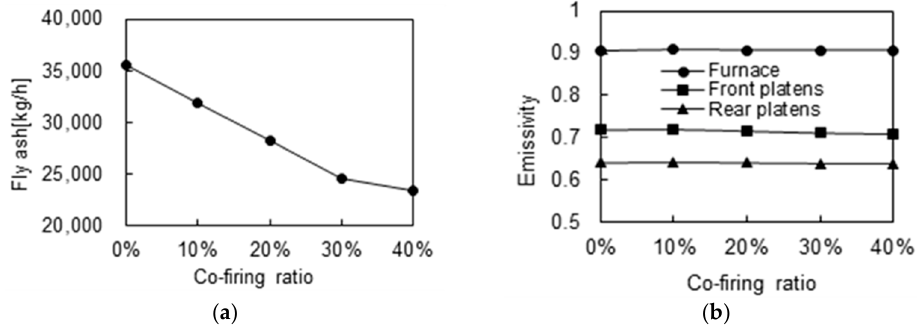
Figure 4. Variations of ( a ) fly ash content and ( b ) flue gas emissivity with the co-firing ratio.